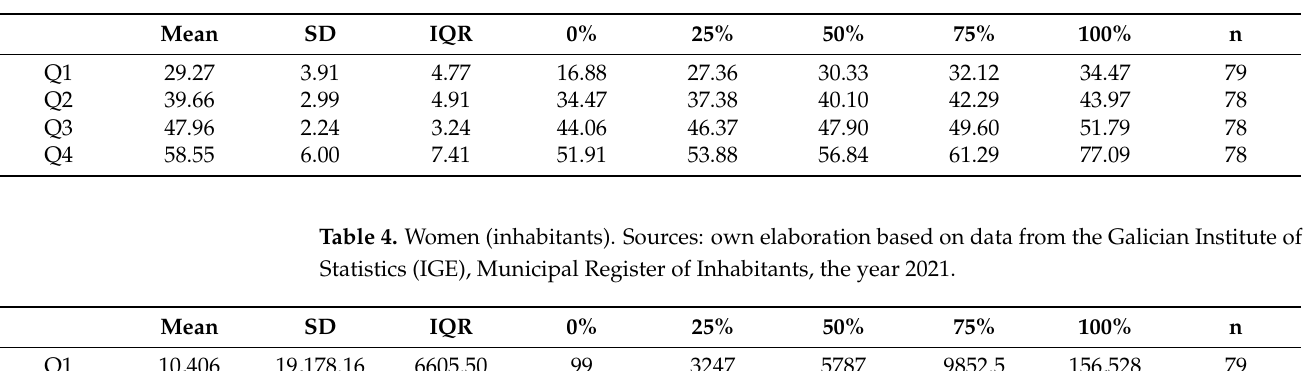
Table 3. ROWVGV . Rate of Women over 64 years of age who are victims of Gender Violence by their current or previous partner throughout their lives ( ROWVGV ). Sources: own elaboration based on data from the Galician Institute of Statistics (IGE), Municipal Register of Inhabitants, 2021, General Council of the Judicial Power CGPJ), Ministry of Equality, and Center for Sociological Research CIS.